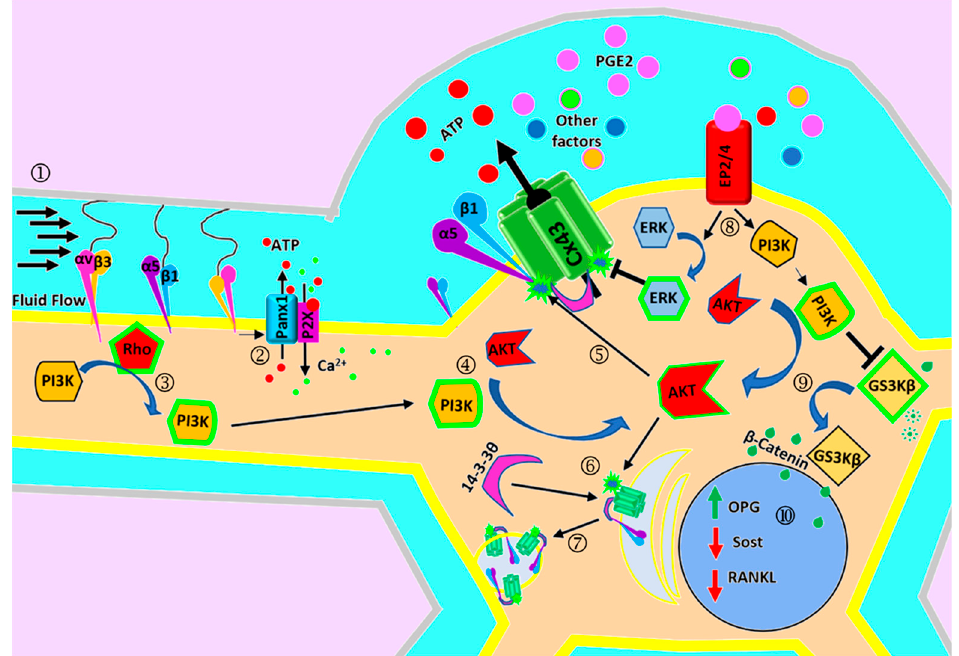
Figure 2. Connexin hemichannels in mechanotransduction of osteocytes. During FFSS, mechanical forces sensed by osteocytic dendrites are transduced through integrins, α v β 3 and α 5 β 1 ( ① ). α v β 3 integrins induce the fast activation of Panx1/P2XR (purinergic receptor) channels and an increase of intracellular Ca 2+ concentration, which propagates as a Ca 2+ wave ( ② ). Moreover, α v β 3 integrin induces the activation of focal adhesion kinases, known activators of signal transduction pathways ( ③ ). Mechanical loading activates the AKT pathway ( ④ ), which promotes the opening of Cx43 hemichannels ( ⑤ ) and stabilizes Cx43/ α 5 β 1 integrin/14-3-3 θ complex, and 14-3-3 θ ( ⑥ ) facilities the translocation of Cx43 and α 5 β 1 integrin to the cell surface ( ⑦ ). The opening of hemichannels leads to a release of factors that promote bone formation and osteocyte survival signaling. For example, PGE 2 released by Cx43 hemichannels activates EP2/4 (prostaglandin receptor) that induces the activation of PI3K singling pathway ( ⑧ ), which leads to inhibition of GSK3 β ( ⑨ ), allowing the accumulation of β -catenin required to modulate bone remodeling genes, such as OPG, RANKL and Sost ( ⑩ ). Moreover, EP2/4 activates the ERK signaling pathway and through direct protein phosphorylation of Cx43, promotes the closure of hemichannels ( ⑧ ).